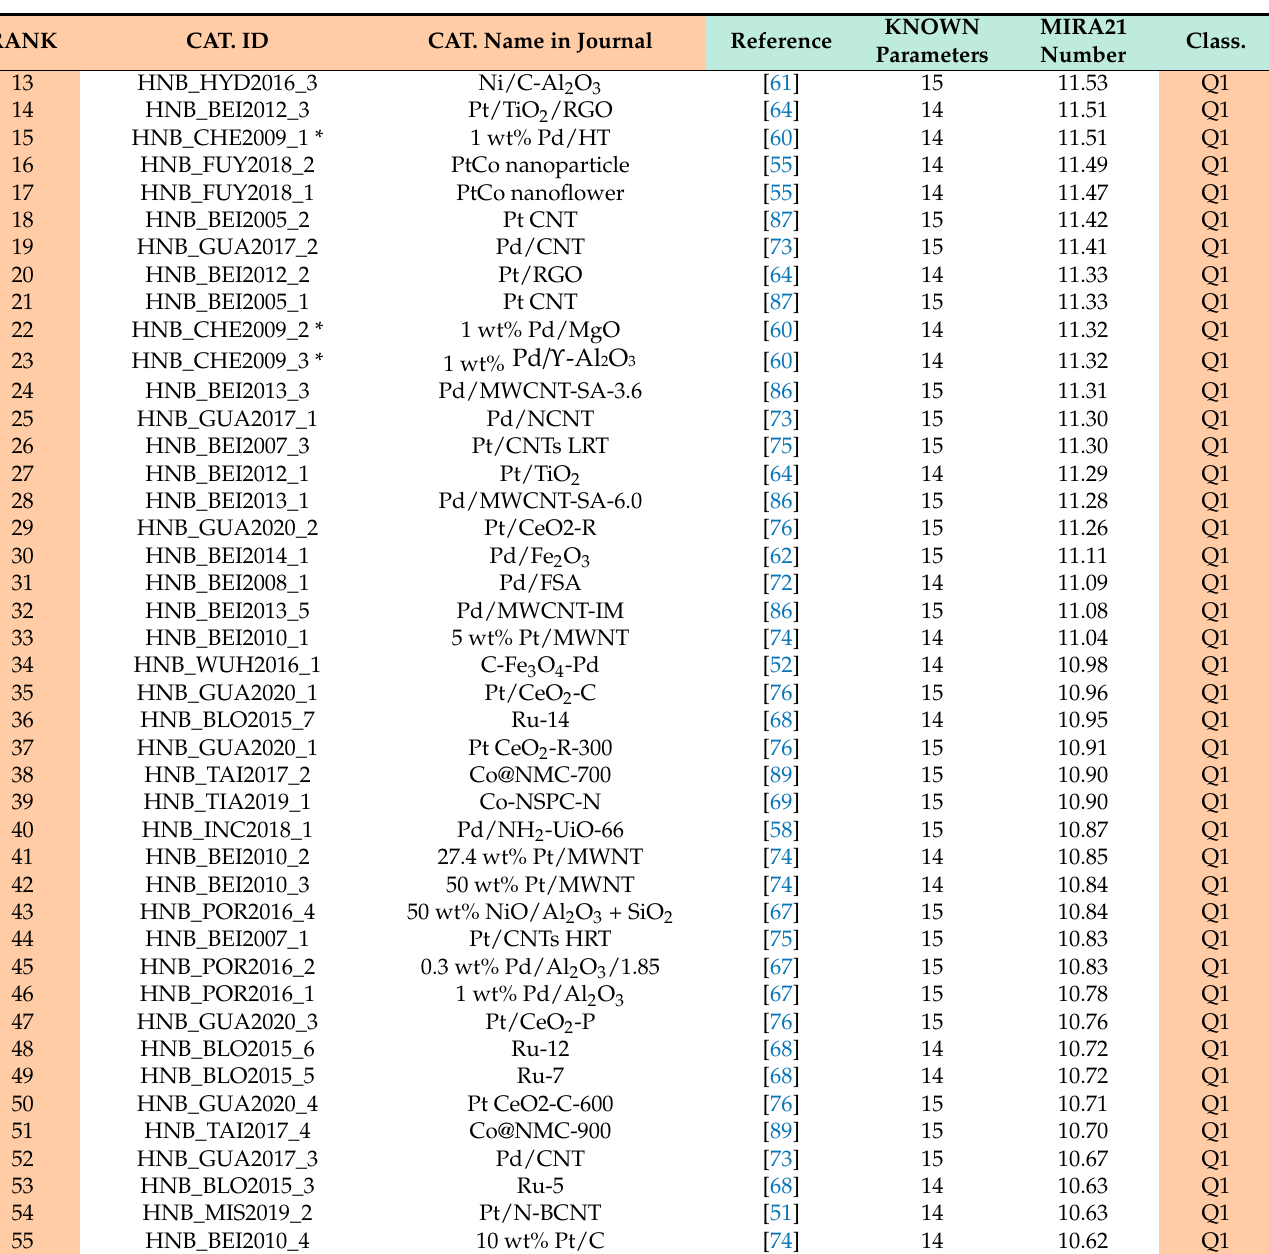
Table 4. List of Q1 catalysts according to MIRA21.